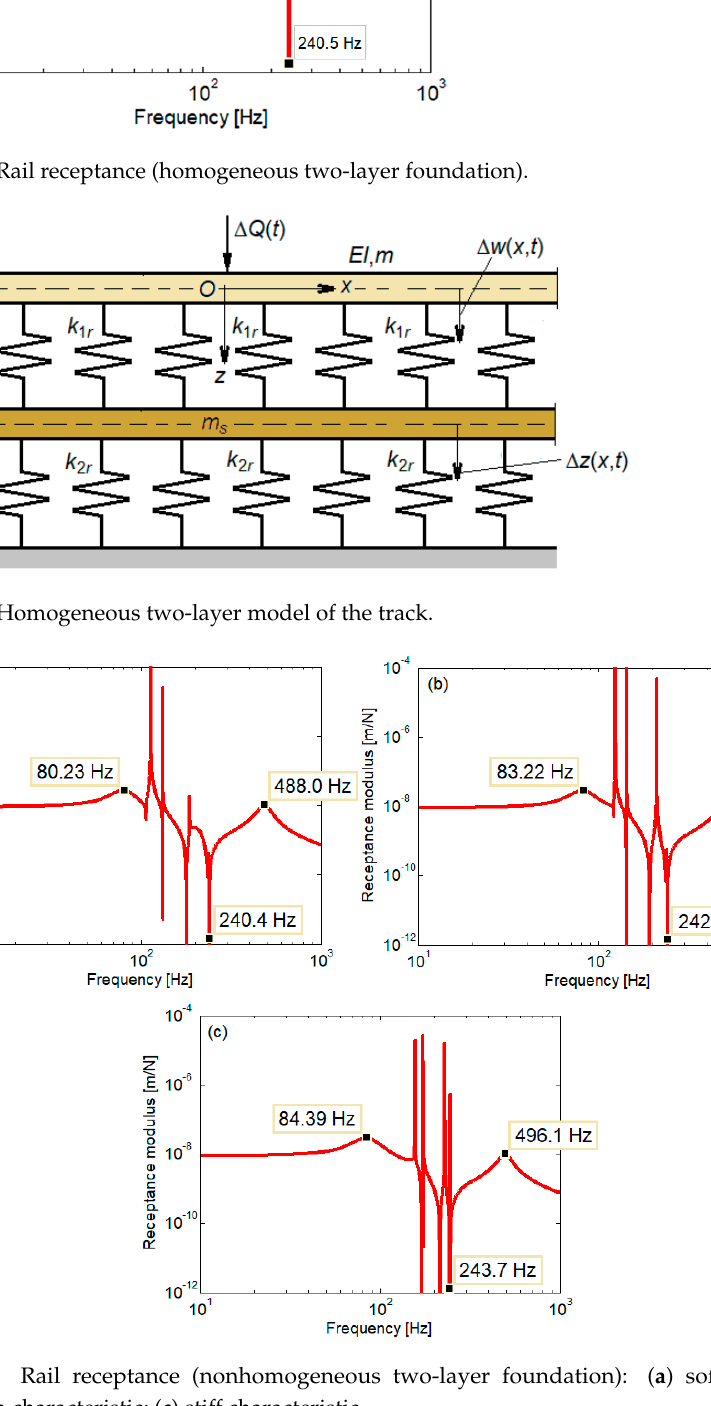
Figure 14. Rail receptance (nonhomogeneous two-layer foundation): ( a ) soft characteristic; ( b ) me- dium characteristic; ( c ) stiff